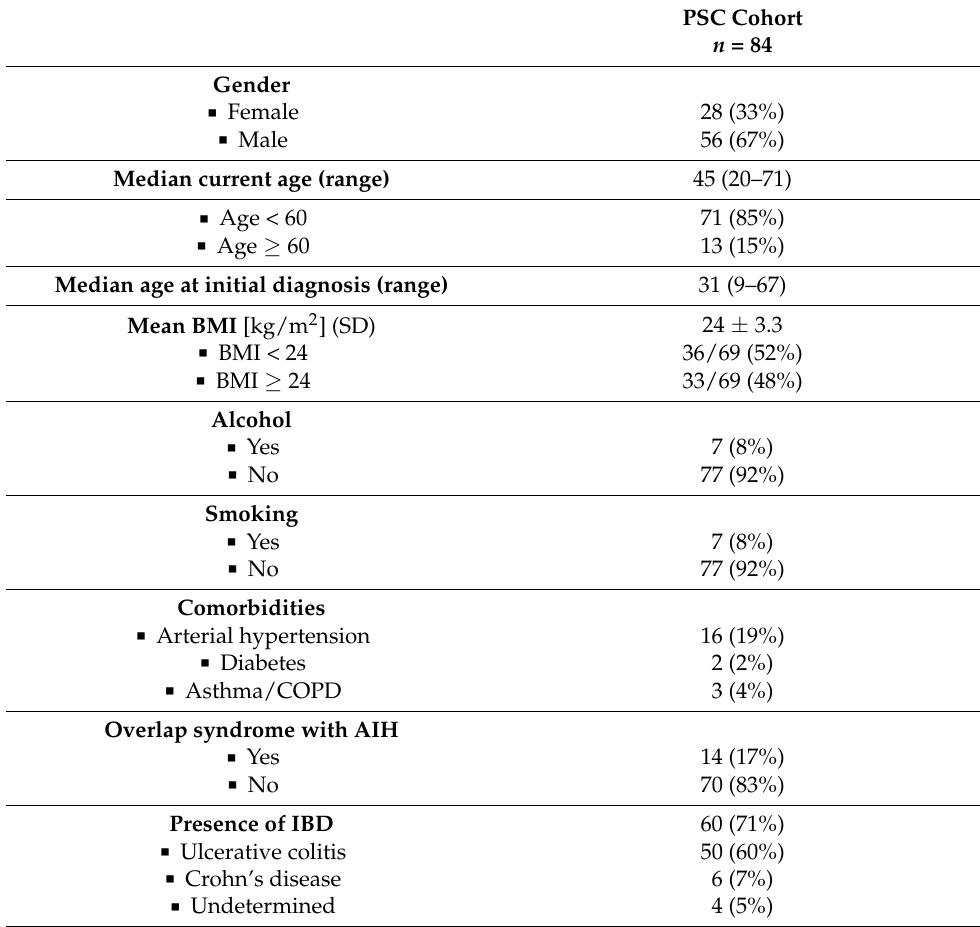
Table 1. Baseline patient and disease characteristics of the PSC